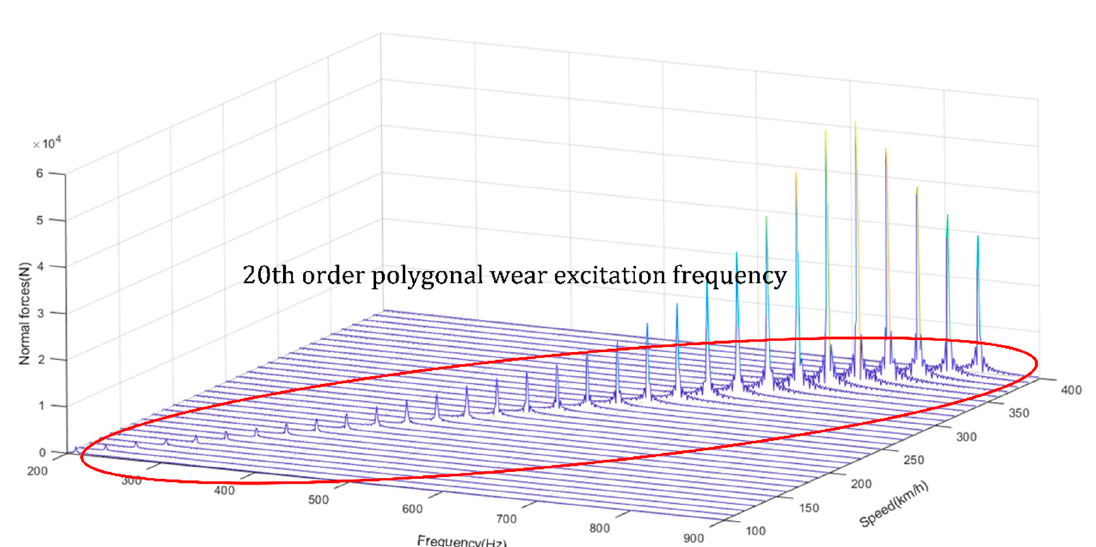
Figure 11. The relationship between the wheel–rail force and the running speed under 20th wheel wear.